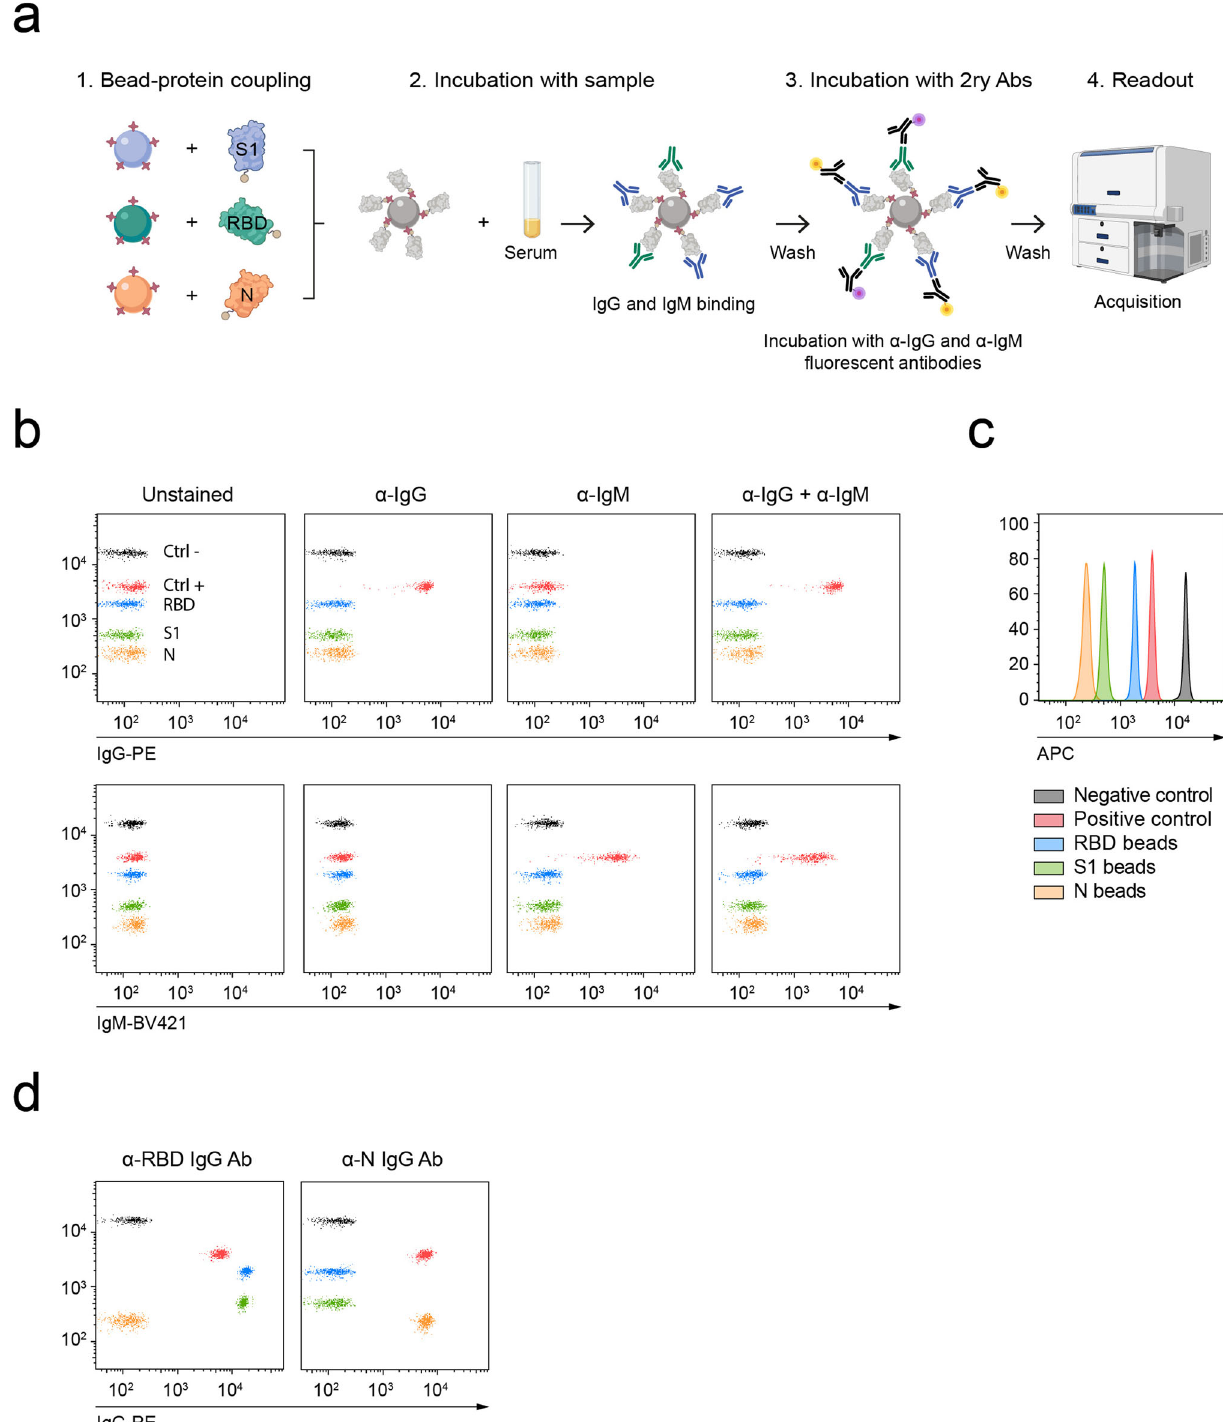
Fig. 1 Work fl ow and performance of C19BA. a Overview of the detection of SARS-CoV-2 seroconversion by fl ow-cytometric bead array. Streptavidin- coated microbeads with different fl uorescence intensities are conjugated with recombinant biotinylated viral antigens (RBD, S1, and N) and mixed and incubated with pre-diluted serum samples together with control beads. After incubation, microbeads are washed and stained with anti-human IgG and IgM secondary antibodies, washed, and acquired on a fl ow cytometer for downstream analysis. Schematic created using BioRender.com. b Dot plots showing the staining patterns of positive (red) and negative (black) control beads with secondary anti-IgG-PE, anti-IgM-BV421, or both. The signal corresponding to IgG-PE (top) and IgM-BV421 (bottom) is shown for each column. c Histogram showing the distribution of the microbeads based on their intrinsic fl uorescence on the APC channel. Each colour represents the coating for each microbead. d Representative dot plots showing the speci fi city of the staining pattern of recombinant anti-RBD IgG (left) or anti-N IgG (right) antibodies.